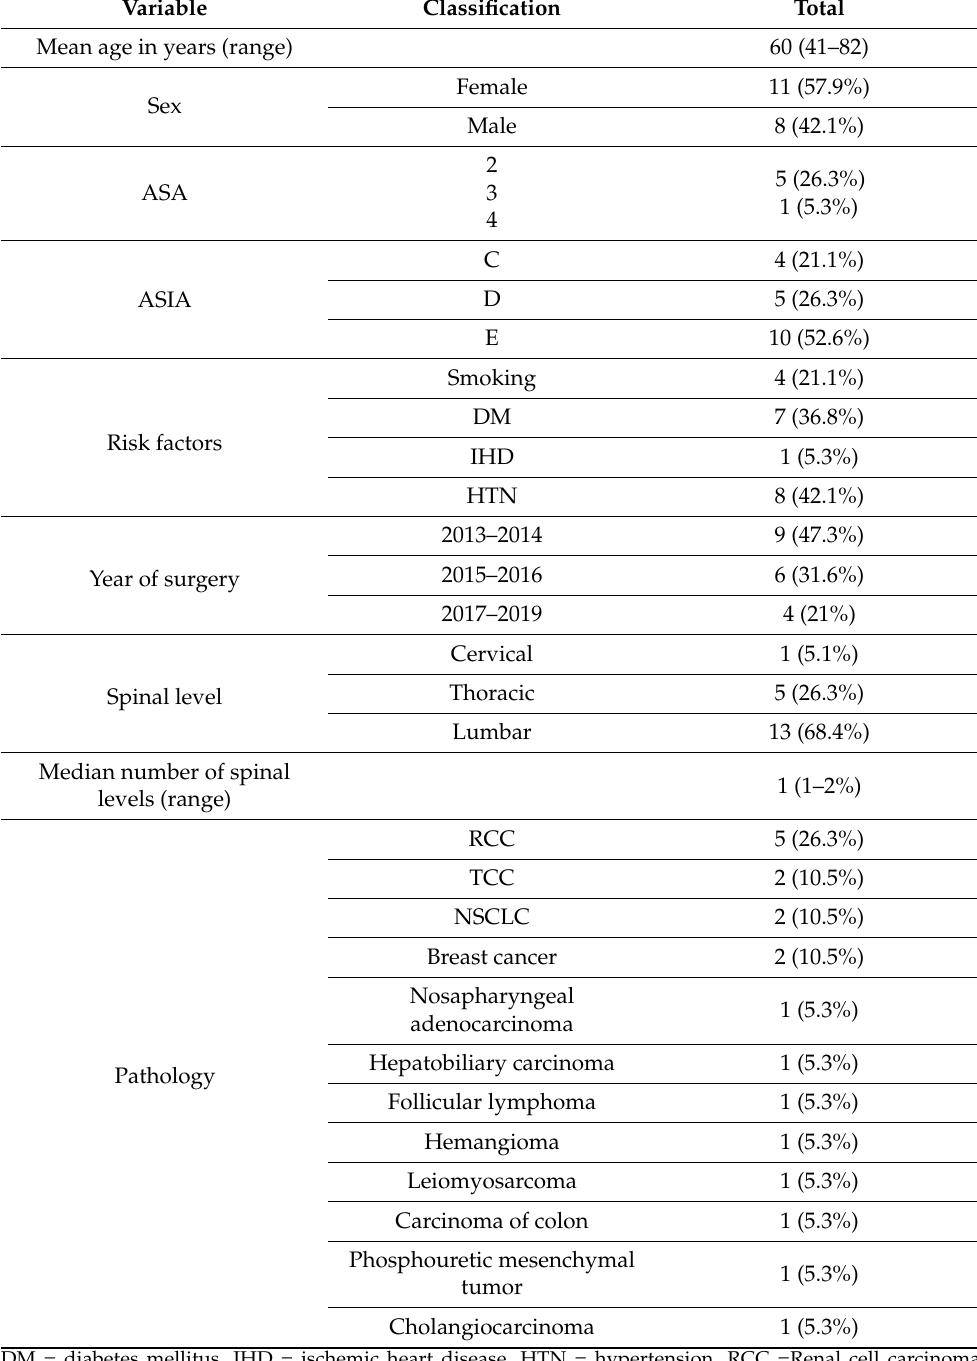
Table 1. Demographic data from 19 patients with epidural spinal tumors.